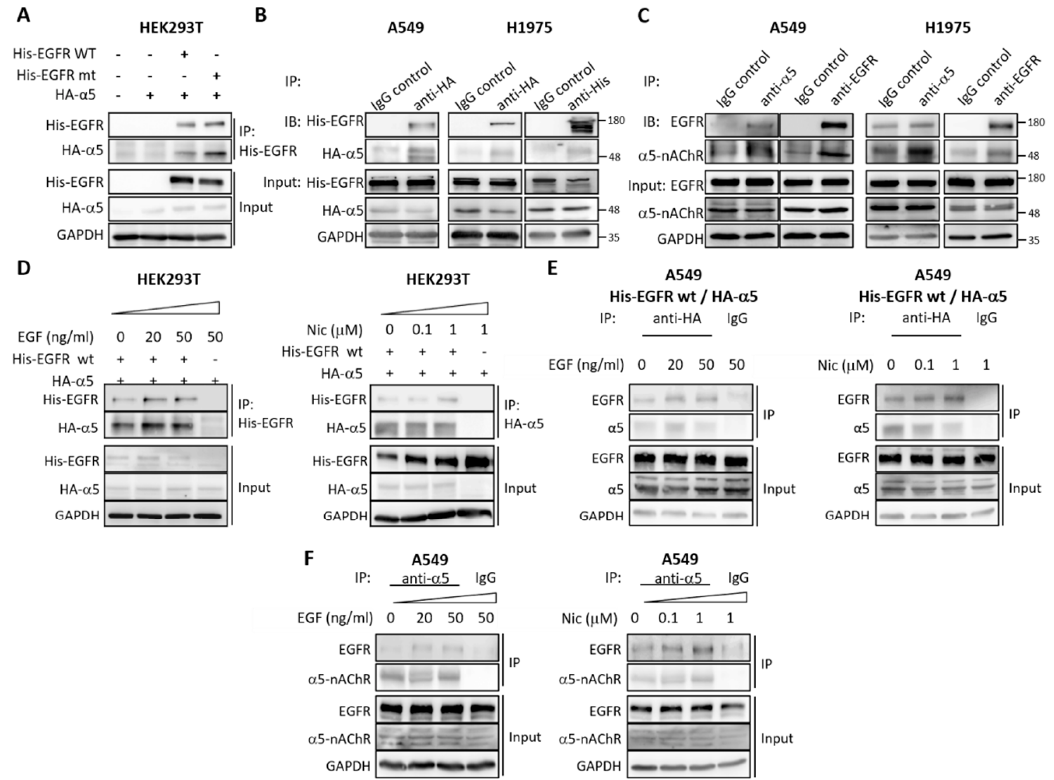
Figure 3. Protein-protein interaction between α 5-nAChR and EGFR. ( A ) His-tagged wild-type and L858R mutated EGFR (His-EGFR WT and His-EGFR-mt) and HA-tagged nAChR α 5 (HA- α 5) expression plasmids were transfected in HEK293T cells, and the cell lysates were subjected to a co-immunoprecipitation assay with anti-His tag antibody to precipitate His-EGFR. The immunoprecipitated complexes were analyzed by western blot. ( B ) A549 and H1975 parental cells were transfected with His-EGFR WT and HA- α 5, followed by immunoprecipitation with anti-HA or anti-His antibodies as described in ( A ). ( C ) Lysates of A549 and H1975 cells were subjected to immunoprecipitation with anti- α 5 or anti-EGFR antibodies to pull down endogenous α 5-nAChR or EGFR, and precipitated proteins were analyzed by western blotting. ( D ) HEK293T cells transfected with His-EGFR WT and HA- α 5 were serum-starved for 8 h before being treated with EGF or nicotine for 1 h. Lysates were immunoprecipitated using anti-EGFR or anti- α 5 antibodies, and precipitated proteins were analyzed by western blot. ( E ) A549 cells transfected with His-EGFR WT and HA- α 5 were serum-starved for 8 h before being treated with EGF or nicotine for 1 h, followed by western blotting. ( F ) A549 cells were serum-starved for 8 h before being treated with EGF or nicotine for 1 h. Lysates were immunoprecipitated using anti- α 5 antibodies, and precipitated proteins were analyzed by western blotting. All data were repeated in at least three independent experiments. The numbers at the right-hand side of the western blots indicates the sizes of the nearest protein markers.